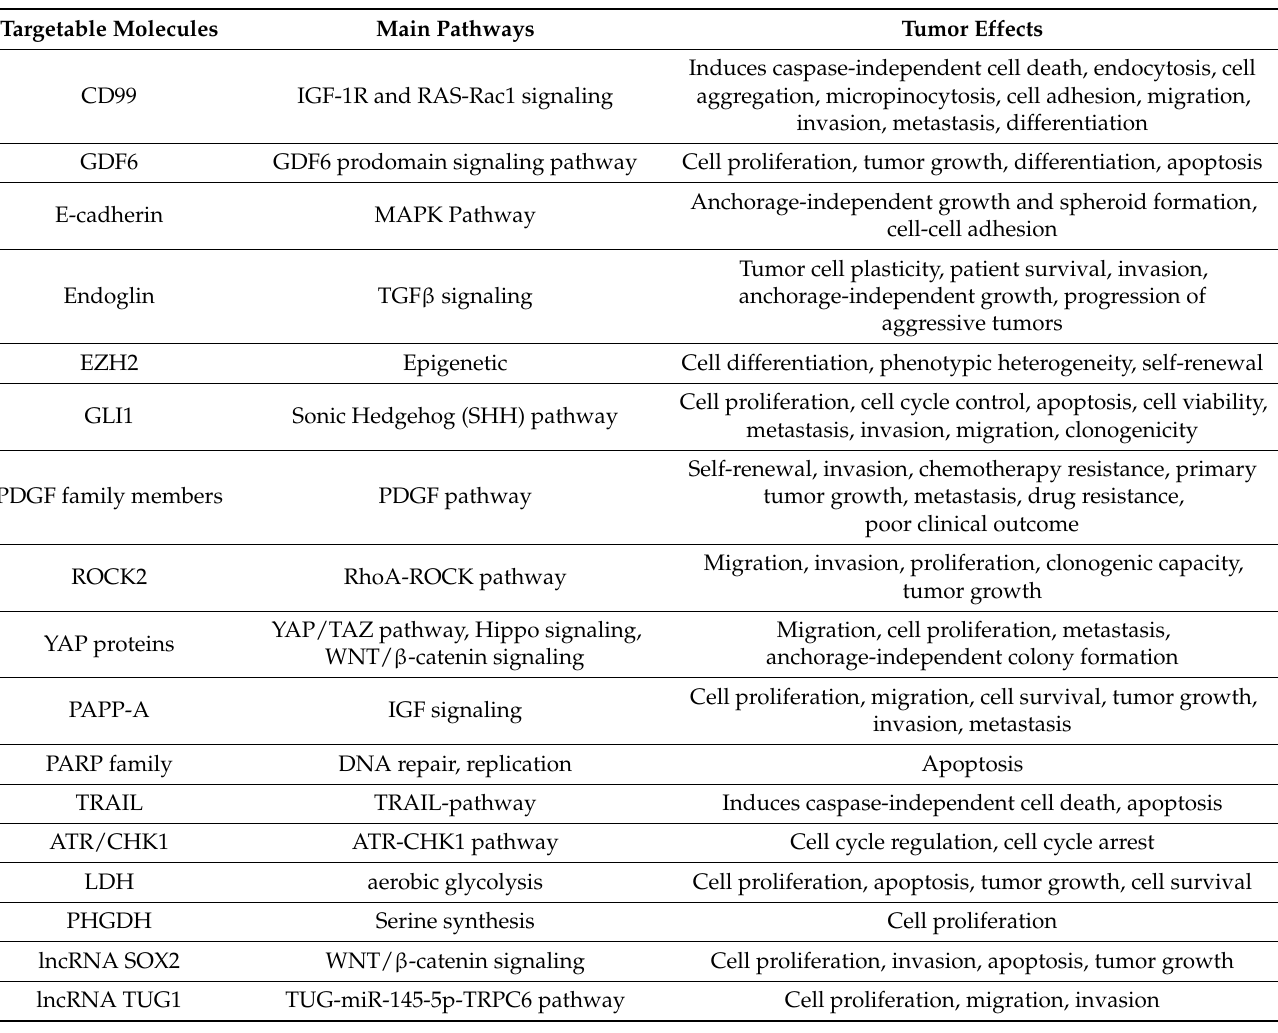
Table 1. Targeting molecules in ES